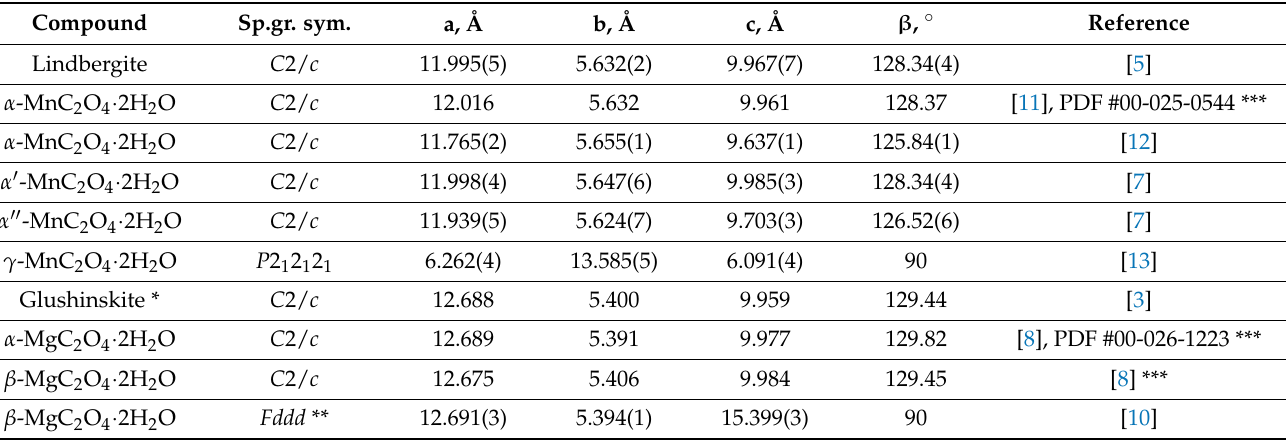
Table 1. Symmetry and unit cell parameters of natural and synthetic oxalates Me 2+ (C 2 O 4 ) · 2H 2 O, Me = Mn 2+ , Mg 2+